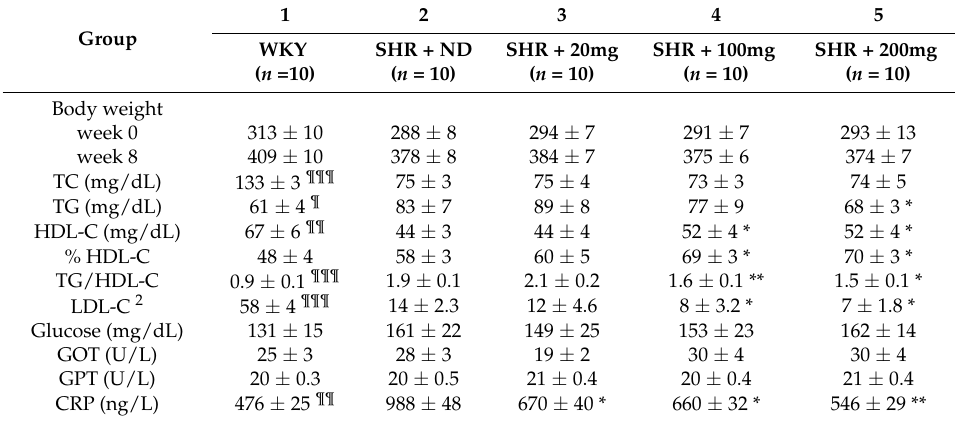
Table 2. Body weight changes and biochemical parameters in the study animals at week 8 1